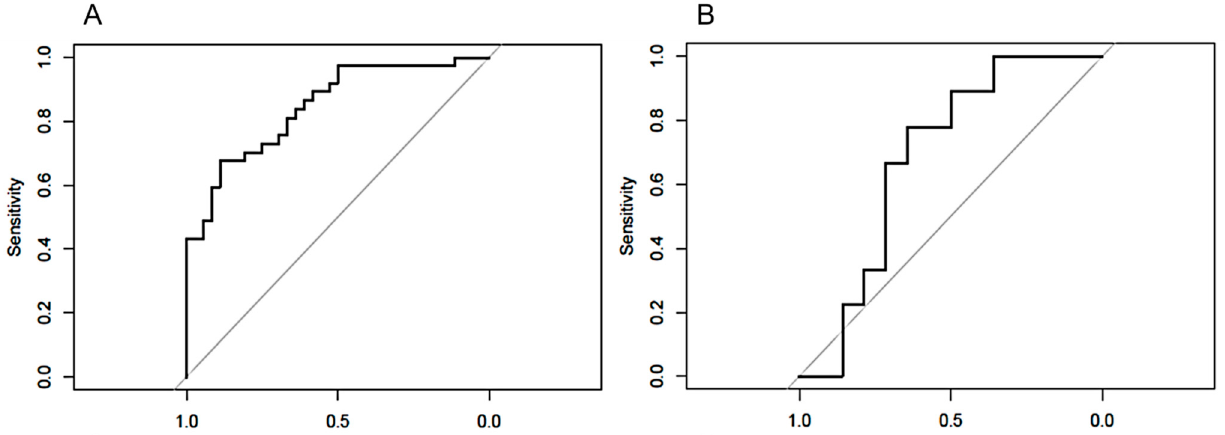
Figure 5. ROC curves of models to predict DMI on the training ( A ) and validation ( B ) sets, to predict LVSI on the training ( C ) and validation ( D ) sets, and to predict low-risk endometrial cancers on the training ( E ) and validation ( F ) sets. 4. Discussion This study showed that MRI-based whole-tumor radiomics analysis yielded me- dium-to-high diagnostic performance for prediction of high-risk surgico-pathological fea- tures in EC, as the presence of DMI and LVSI. Furthermore, we explored the capability of MRI-based radiomics for preoperative prediction of risk class in EC. The radiomics model developed in our study showed a moderate-to-good ability to discriminate between low- risk EC and the other classes, with promising reproducibility and reliability, as confirmed by the external validation process (TRIPOD 3).